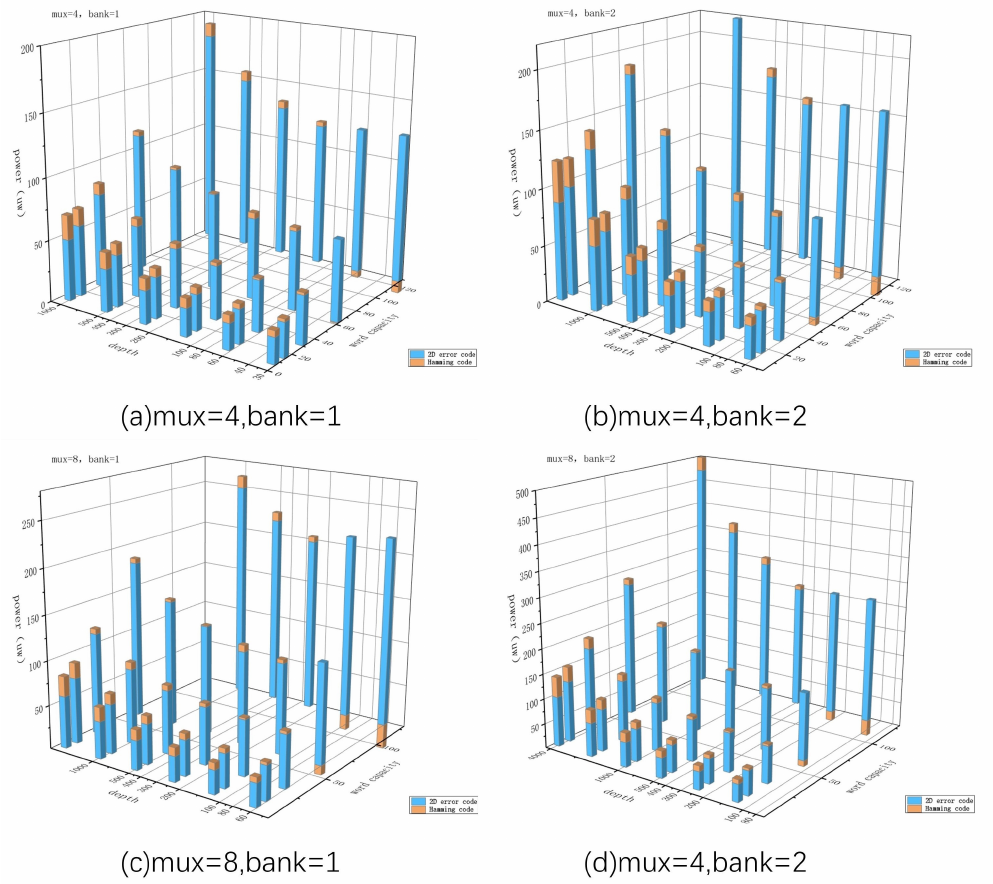
Figure 5. Power consumption comparison between Hamming code and two-dimensional error correction